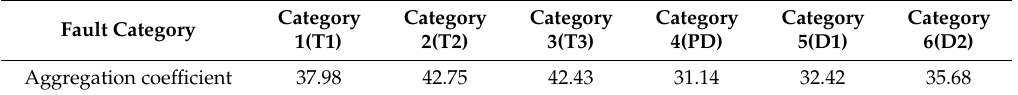
Table 1. Failure aggregation coe ffi cient of raw data.